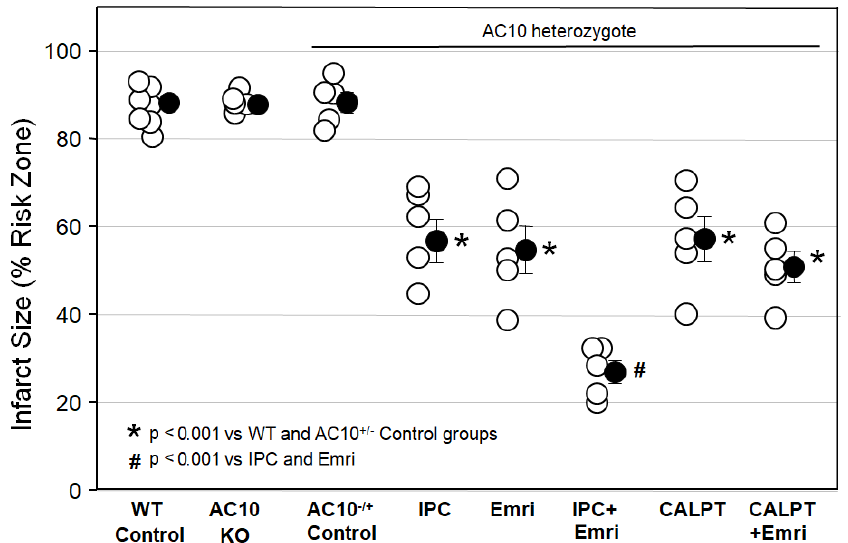
Figure 1. Infarct size as a percentage of risk zone in isolated male mouse hearts undergoing 50 min global ischemia/2 h reperfusion. Open circles represent individual hearts, and solid circles represent means ± SEM. Abbreviations: AC10, soluble adenyl cyclase; CALPT, calpeptin; Emri, emricasan; IPC, ischemic preconditioning; KO, knockout; WT, wild type.